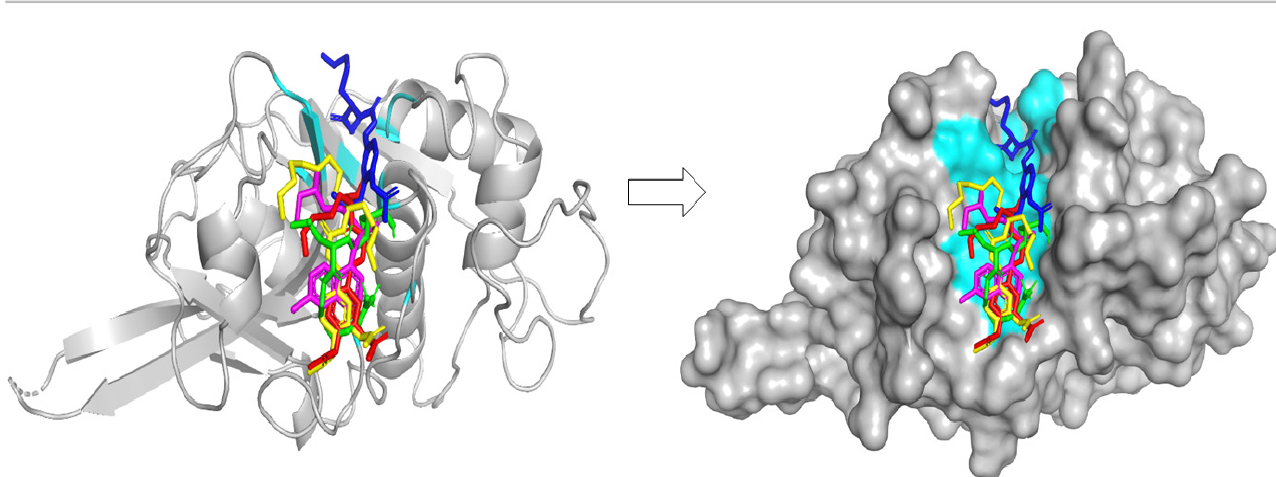
FIGURE 7 - Superposition of the best docked conformation of hybrids 1,2,6 and positive references alongside the hemoglobin cleavage site on FP-2. Hybrids 1 ( in red ), 2 ( in blue ), 6 ( in yellow ) and current inhibitors E64 ( in green ) and Chloroquine ( in magenta ). Critical aminoacids into the hemoglobin cleavage site are represented in